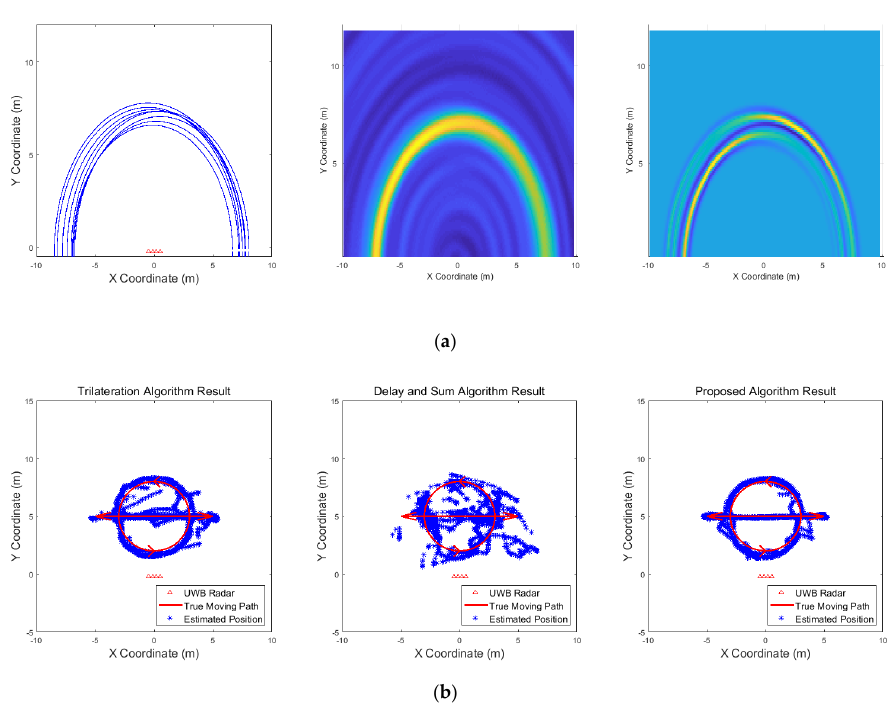
Figure 18. Simulation results when one target moves in a circle and one target moves horizontally (Scenario 10): ( a ) instantaneous results of position estimation step according to the positioning algorithm; ( b ) results of the radar system for the entire simulation.